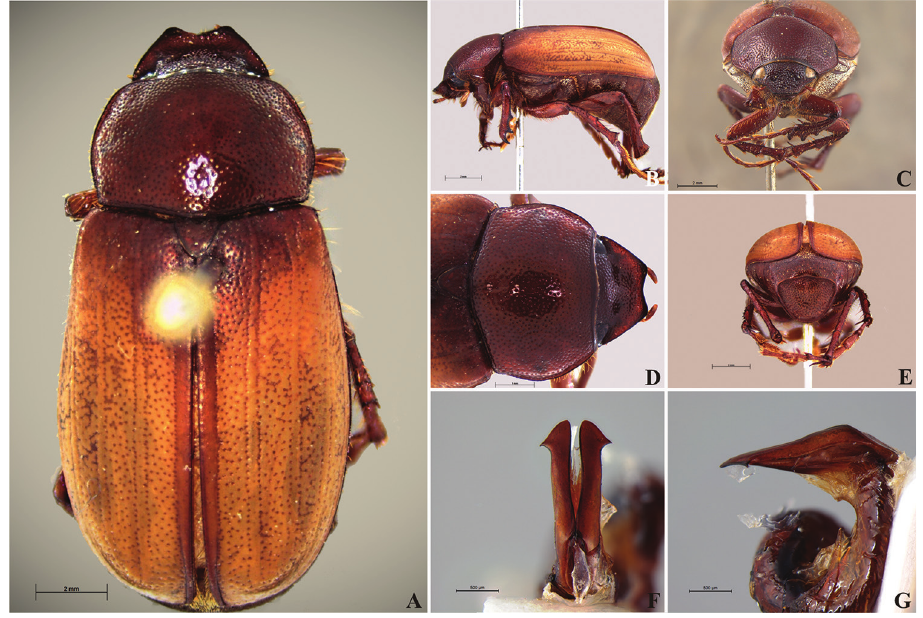
Figure 74. Liogenys suturalis (Blanchard). A Dorsal view B Lateral view C Frontal view D Clypeus and pronotum E Pygidium F Parameres, dorsal view G Parameres, lateral